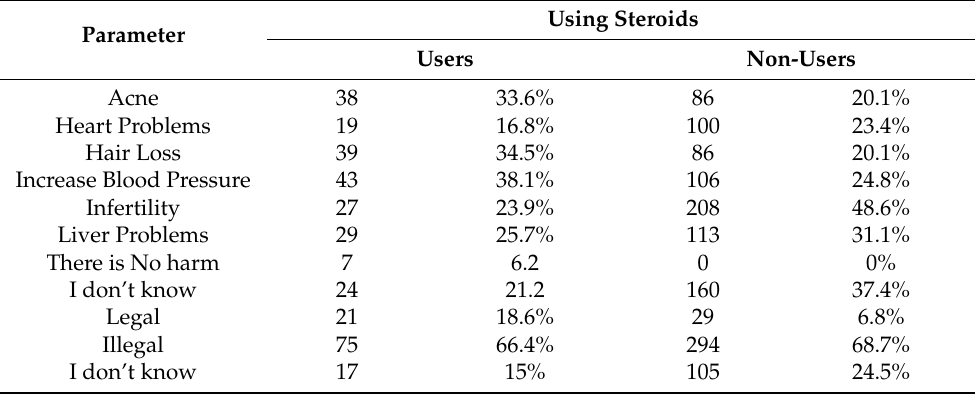
Table 4. Knowledge about the adverse effects of anabolic